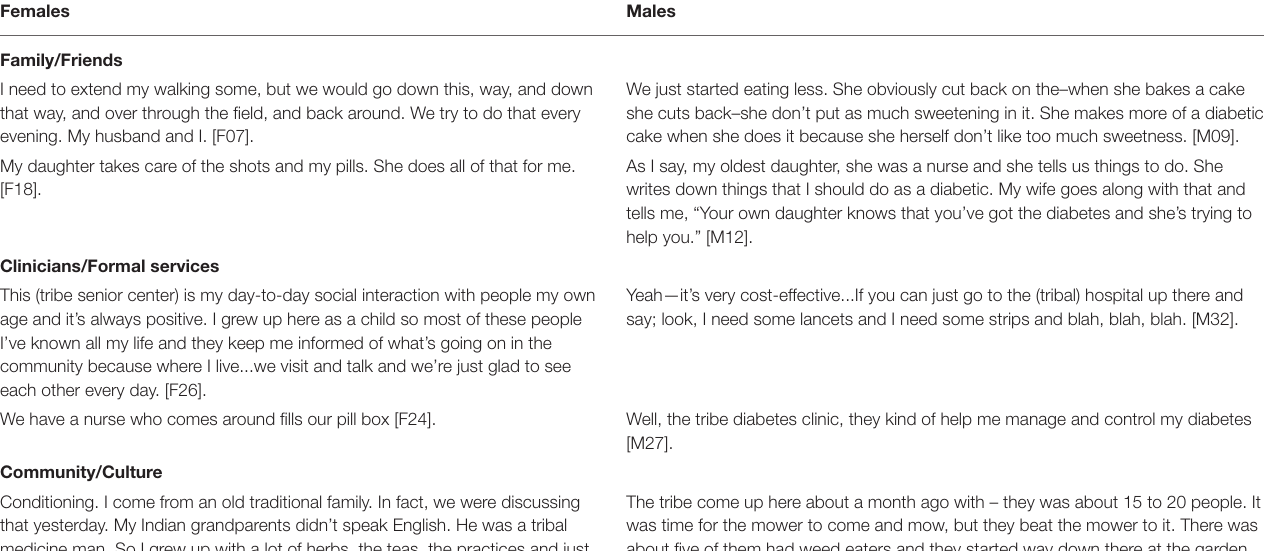
TABLE 2 | Exemplar quotes by support source. Females